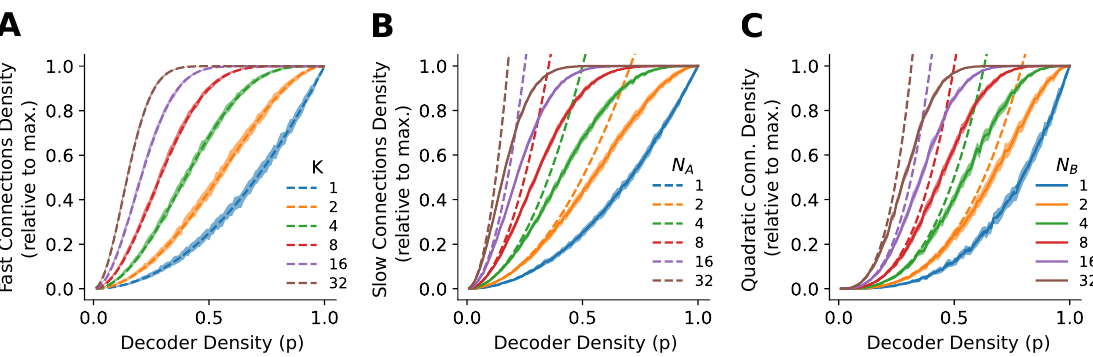
Figure 4 – Expected connectivity density relative to all-to-all connectivity for the differ- ent synapse types as a function of the decoder density p . Solid lines illustrate mean across 1 standard deviation from the average of iterations, whereas shaded areas represent ± the simulated connectivity (see Methods 7.8). Dashed lines correspond to theoretical upper bounds (Eq. 8-10). ( A ) The connectivity density for the fast synapses for different signal dimensions ( K ). ( B ) The connectivity density for the slow synapses due to linear N A p 2 ), for different linear dynamical system densities ( N A ). ( C ) The computation (i.e. ∼ connectivity density for slow multiplicative (quadratic) synapses, for different quadratic dynamical system densities ( N B ). N A and N B represent the number of non-zero entries of matrices A and B